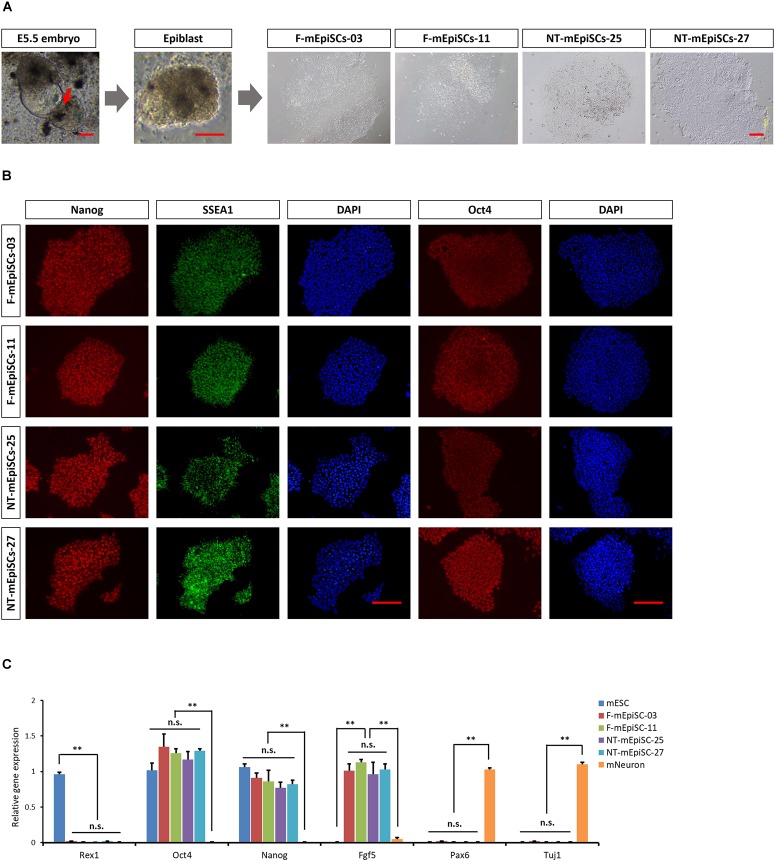
Derivation and characterization of mouse EpiSCs from in vivo fertilization and NT embryos. (A) Mouse embryo at E5.5 stage, isolated epiblast layer, and morphology of established F-mEpiSCs and NT-mEpiSCs. (B) Immunofluorescence staining for Nanog, SSEA1, and Oct4 in F-EpiSCs and NT-EpiSCs; nuclei are shown using DAPI. (C) Gene expression analysis by qPCR for EpiSC-specific markers, pluripotency markers, and neural marker in four selected mEpiSCs. Scale bar: 100 μm; n.s., P > 0.05; ∗∗P < 0.01.